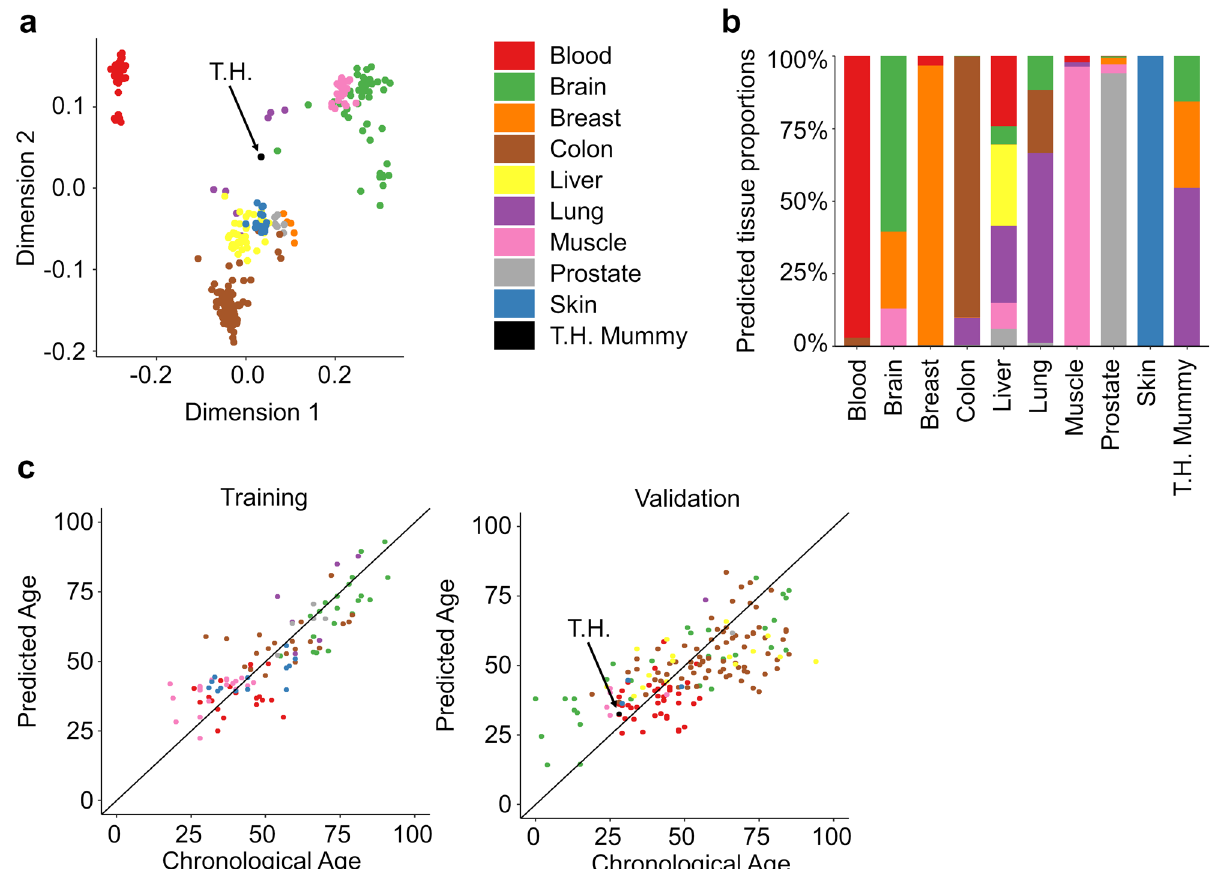
Figure 2. Epigenetic classification of the DNA methylation profile. For the subsequent DNAm classification of the sample from the mummy of T.H. we focused exclusively on 22,778 CpGs that passed the filter criteria. ( a ) Multidimensional scaling (MDS) plot of the top 100 most variable CpGs in 301 Illumina EPIC BeadChip profiles of nine different tissues and the mummy sample. ( b ) Tissue specific DNAm signatures were trained for the filtered CpGs (5 CpGs per tissue) and used for a deconvolution algorithm. The tissue-predictions are exemplary depicted for samples of the validation set and for the T.H. sample. ( c ) Age predictors were trained for 7 CpGs of the Horvath aging clock 7 that were comprised in the filtered CpGs. Age-predictions correlated with chronological age in the training set (R 2 = 0.71) and validation set (R 2 = 0.43; two outliers are not